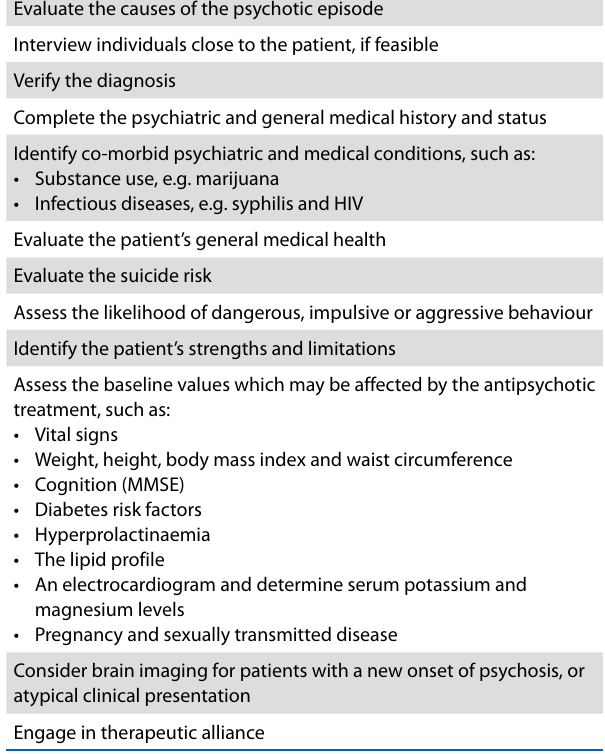
Table 3: The assessment of schizophrenia Evaluate the causes of the psychotic episode